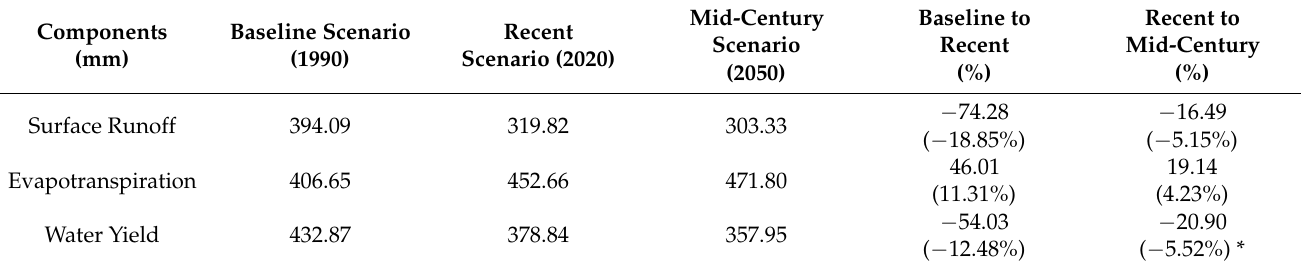
Table 7. Comparison between water balance components under LU/LC